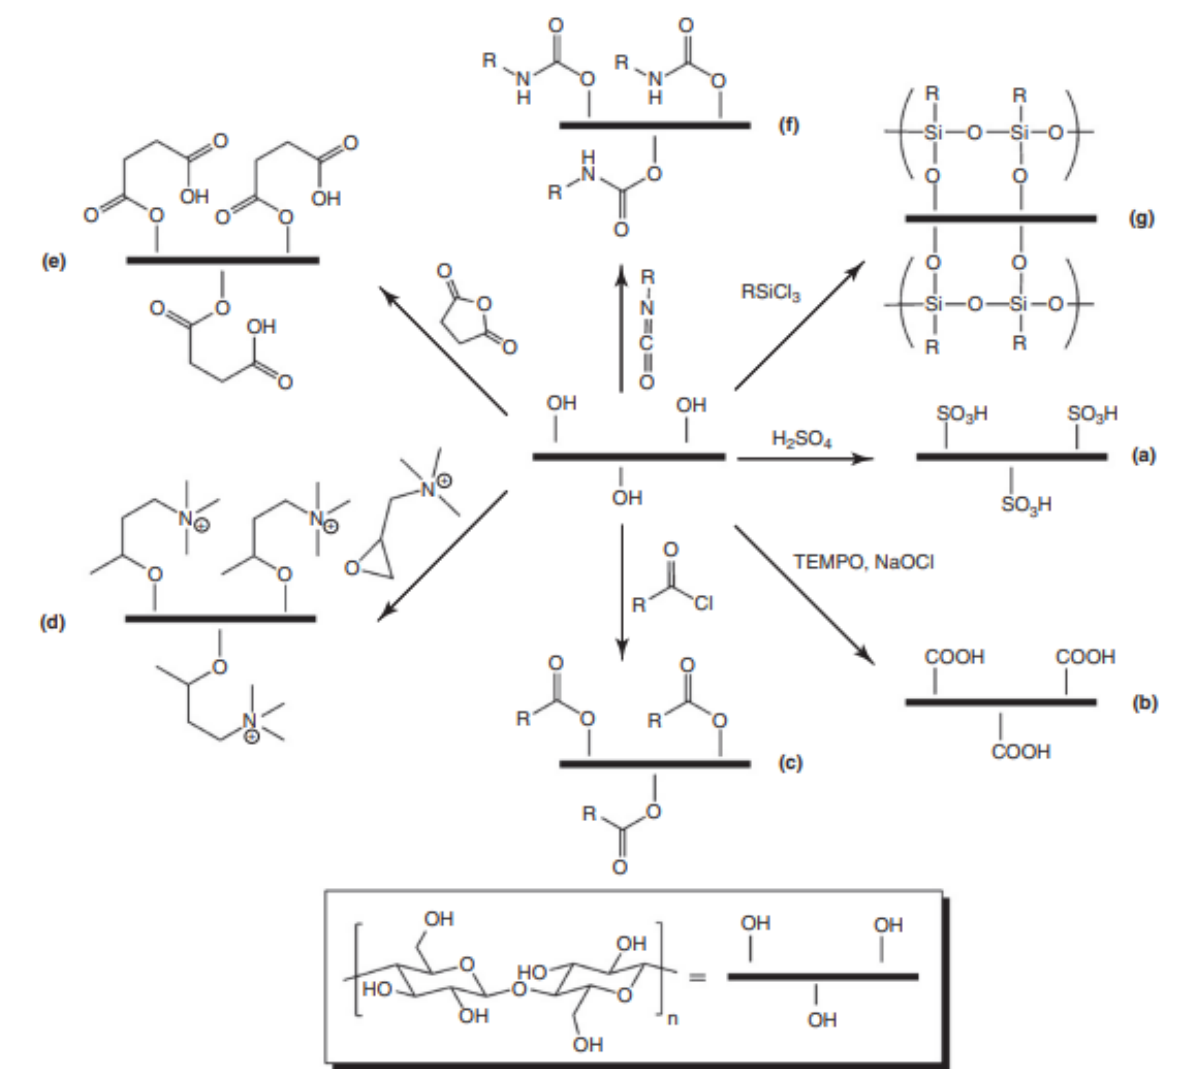
Figure 5. Some possible routes for chemical modification of nanocellulose: ( a ) sulfonation; ( b ) oxidation by TEMPO; ( c ) ester linkages via acid chlorides; ( d ) cationization via epoxides; ( e ) ester linkages via acid anhydrides; ( f ) urethane linkages via isocyanates; and ( g ) silylation. Adapted from Ref. [79].